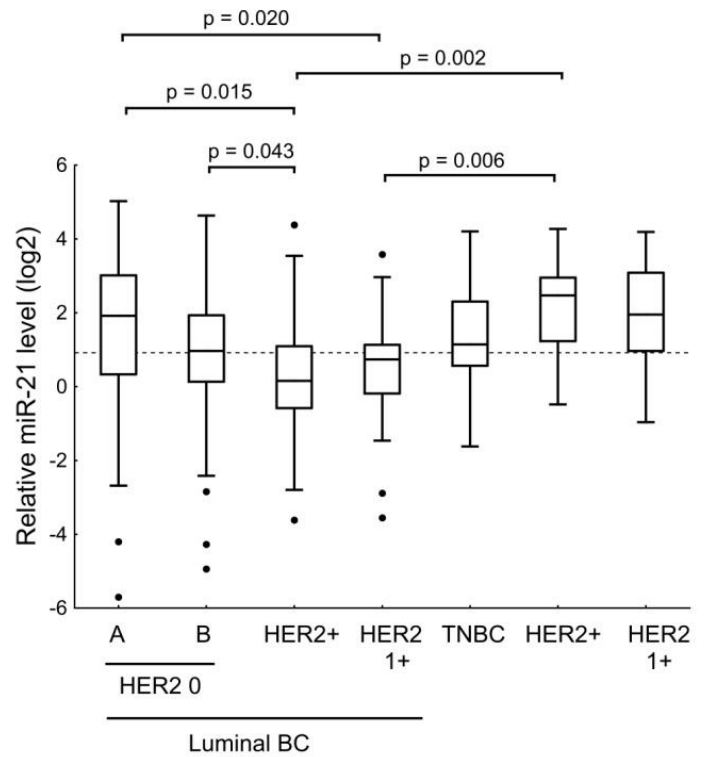
Figure 11. The comparison of miR-21 expression between different BC subtypes. HER2+ = HER2 amplification. Tumors with HER2 IHC scores of 1+ were treated as a separate group. The Y axis presents the expression level (log 2 – ∆∆ Ct ); the results were normalized to the control (normal tissue).